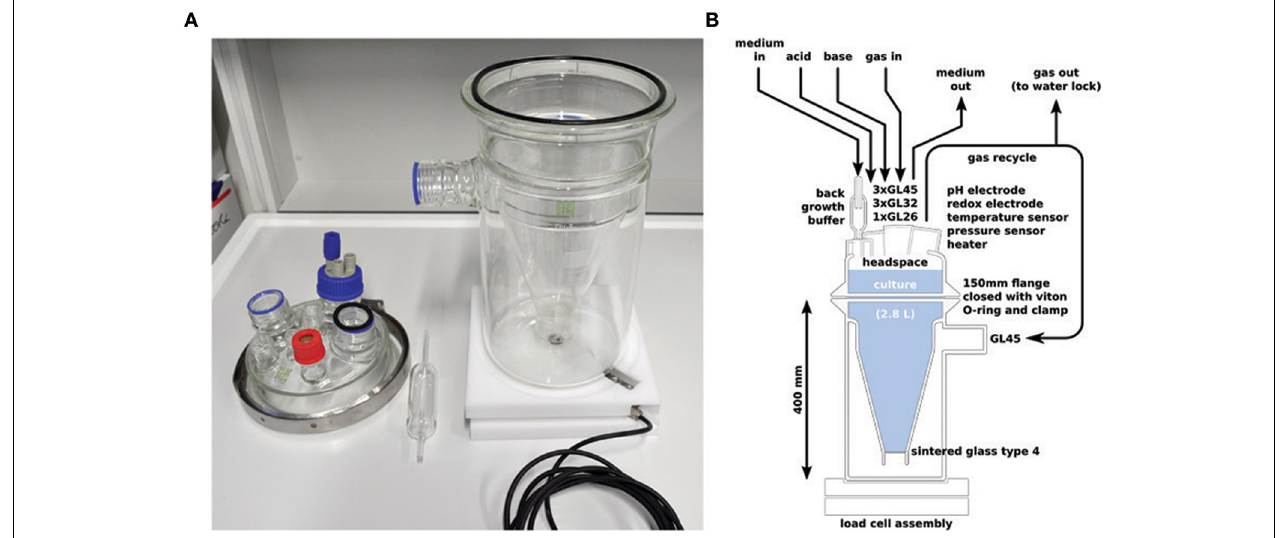
FIGURE 1 | The chemostat vessel used, photo (A) and schematic (B). All additions and withdrawals were made from the top of the vessel. The vessel was mixed by recycling gas from the headspace to the bottom via a sintered